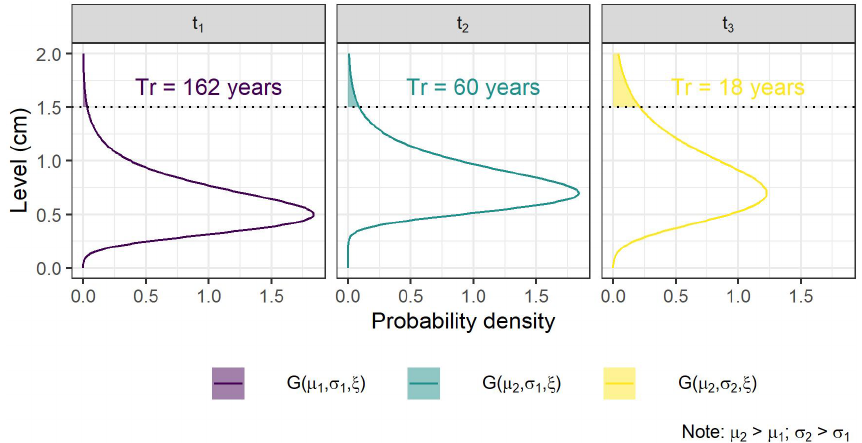
Figure 1. Example of the effects of curves parameters on the return period estimation for a sea level > 1.5m. GEV curves with different location ( µ ) and scale ( σ ) parameters corresponding to three time periods are represented. The shape ( ξ ) parameter is kept constant The return period is calculated based on the highlighted area (see Sect. 2.3.8). Different locations and scales yield different return period estimates. Under non-stationary conditions, the curve’s parameters change with